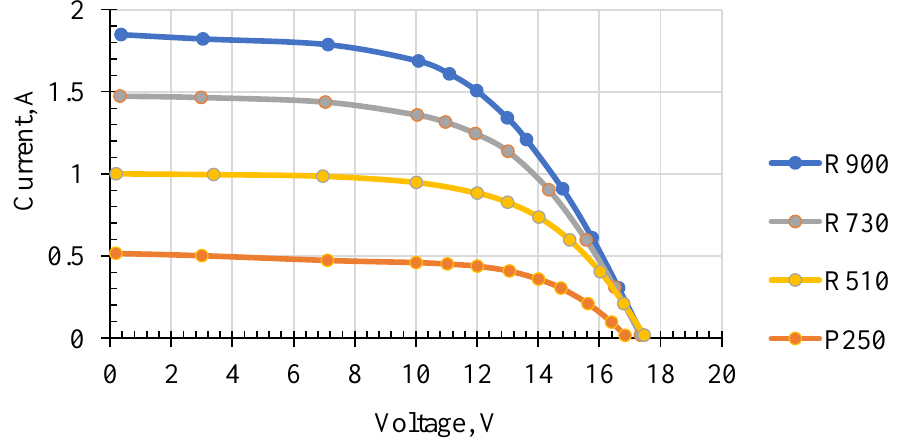
Figure 9. VAC of a PVM at different solar radiation intensities: (R900) at an average intensity of 900 W/m 2 ; (R730) at 730 W/m 2 ; (R510) at 510 W/m 2 ; (R250) at 250 W/m 2 . The obtained VACs were converted into the volt-watt characteristics (VWCs) of the photovoltaic module, shown in Figure 10.